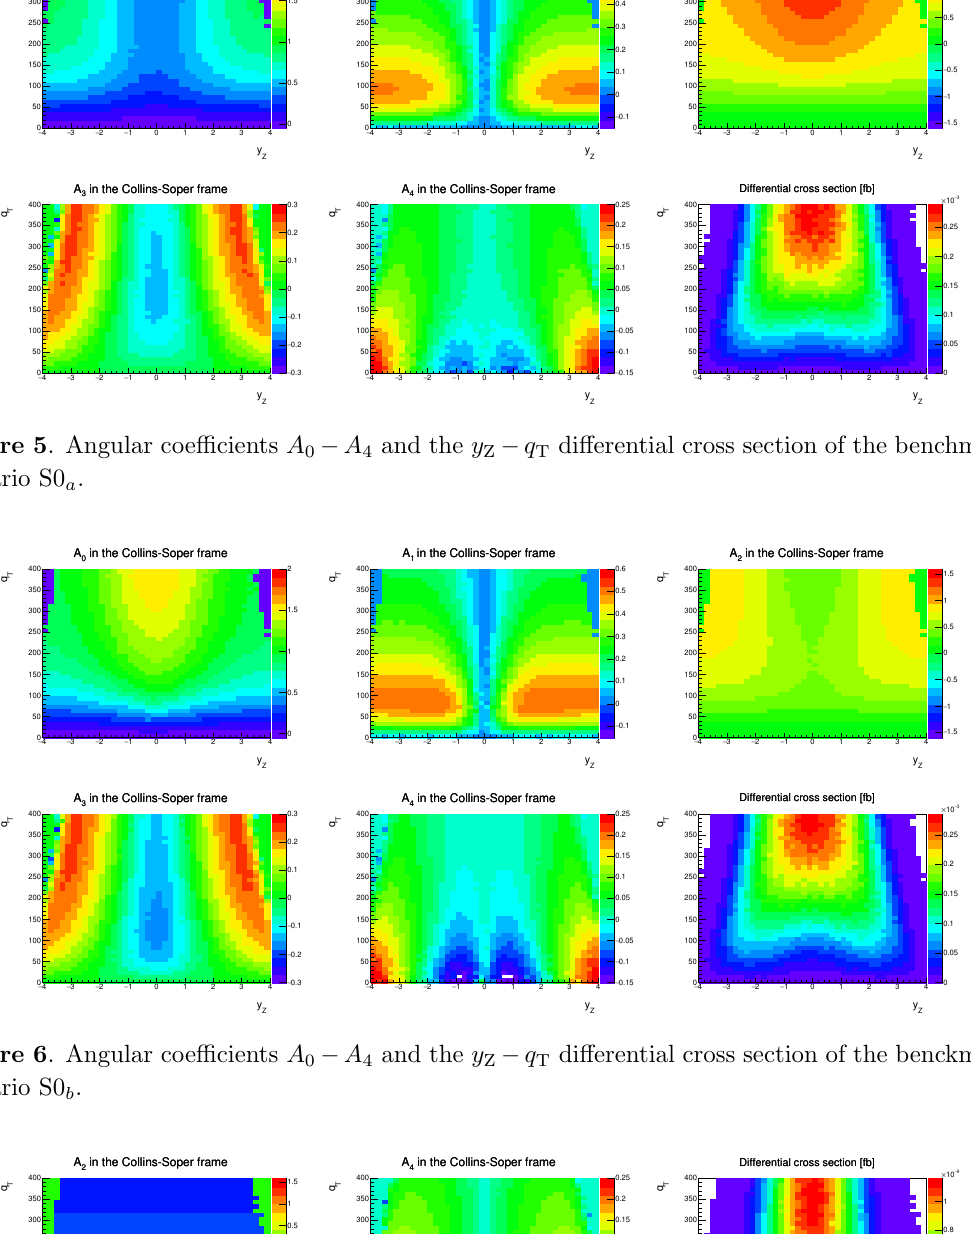
A 4 and the y Z q T di(cid:11)erential cross section of the bench- (cid:0) (cid:0)